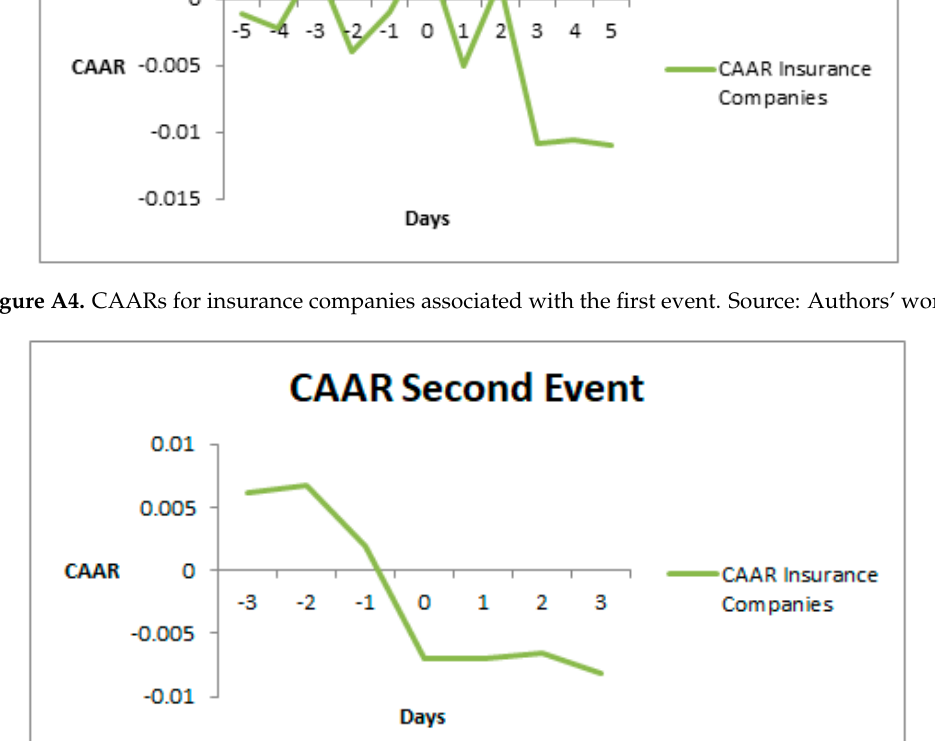
Figure A5. CAARs for insurance companies associated with the second event. Source: Authors’ work.